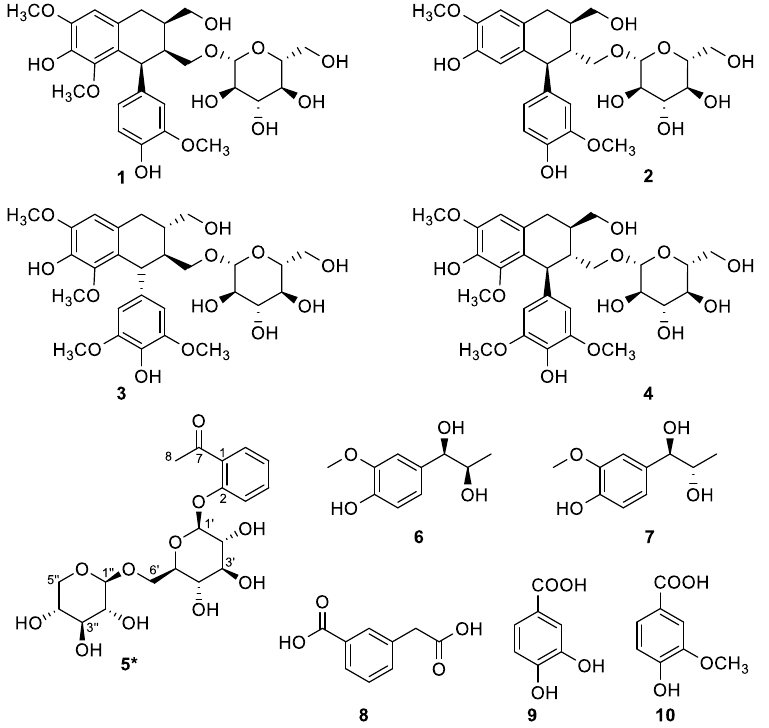
Figure 2. Chemical structures of compounds 1 – 10 isolated from C. spinarum (* new compound). Table 2. 1 H NMR (600 MHz) and 13 C NMR (125 MHz) data of compound 5 in CD 3 OD.